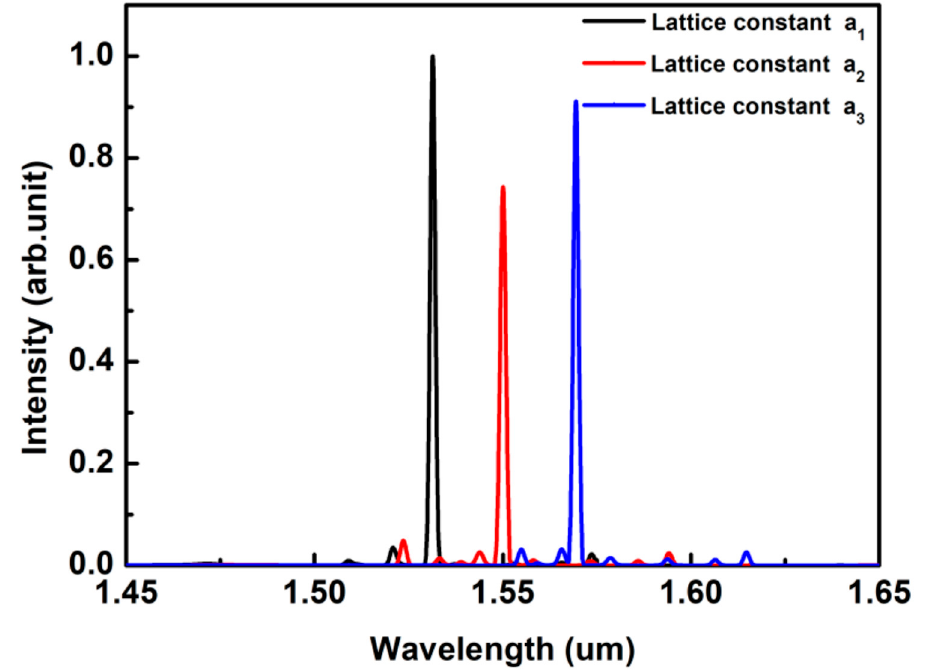
Figure 7. Output spectra of the multi-wavelength PhC-DBR NW laser array. All the longitudinal modes belong to HE11 x . The radius is 120 nm.